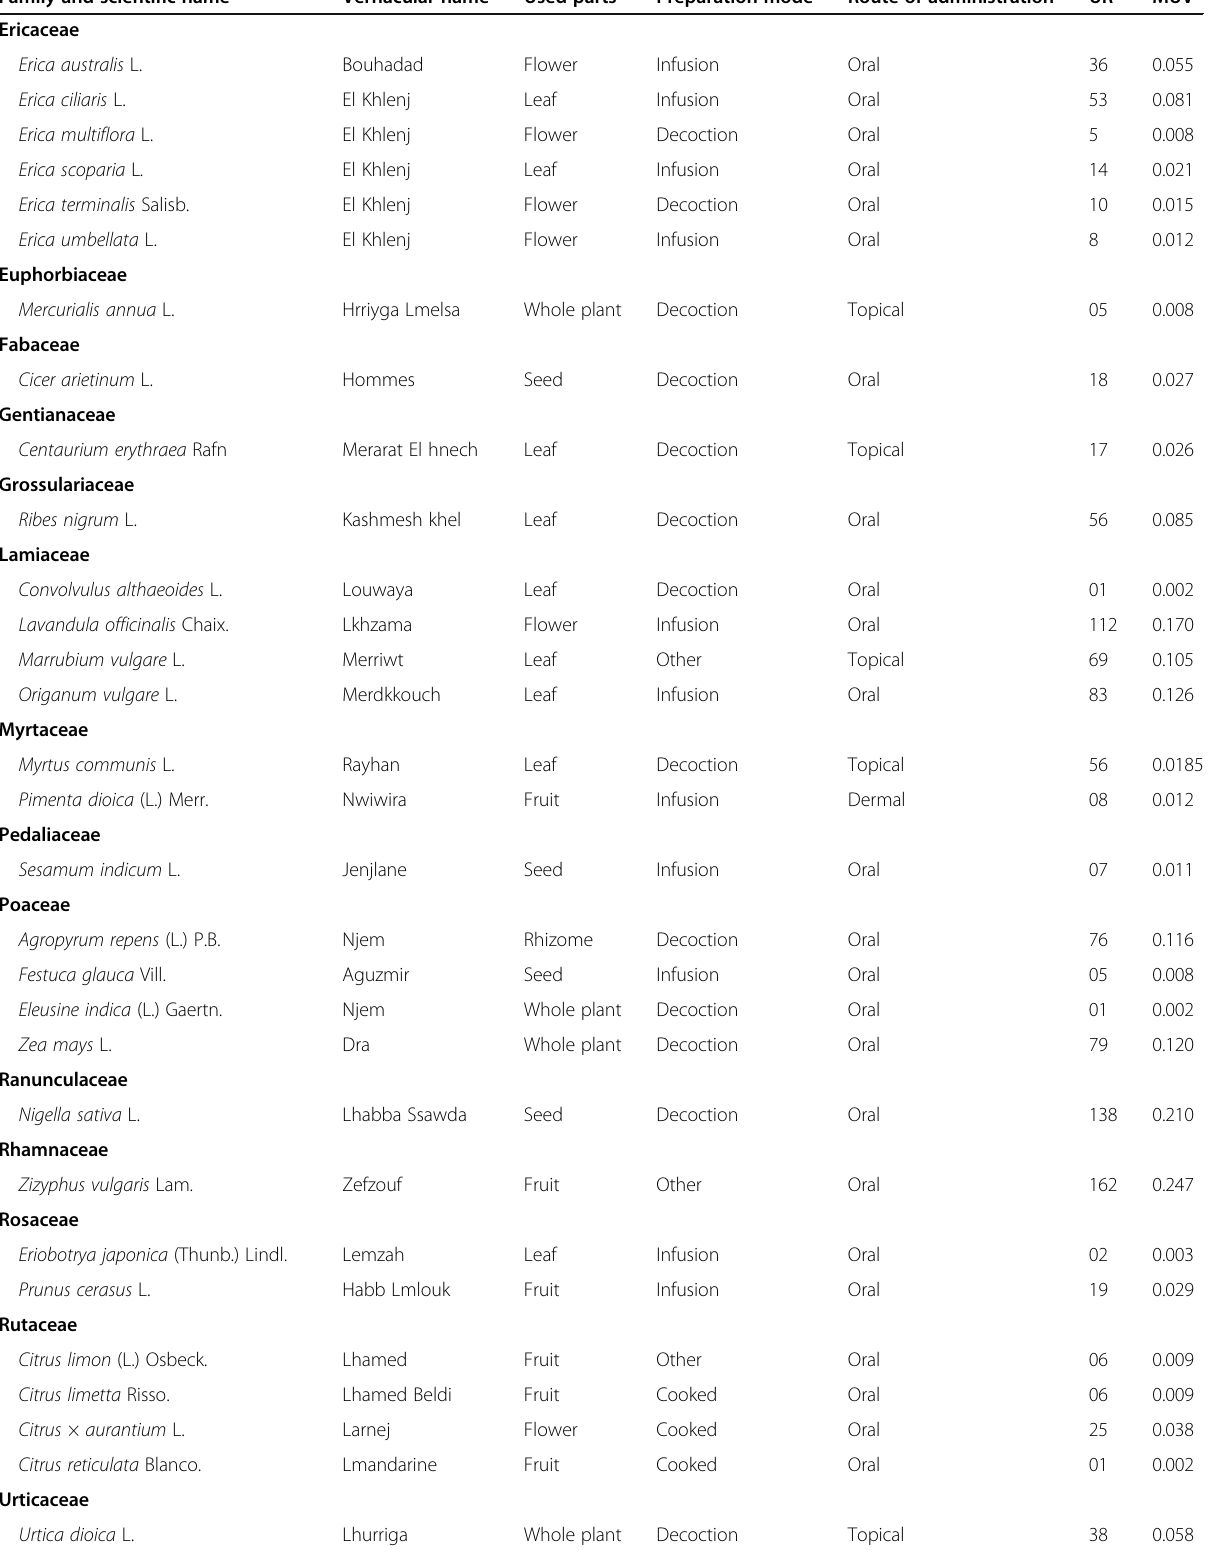
Table 2 Catalog of medicinal plants used to treat cystitis problems in the Rif, Morocco